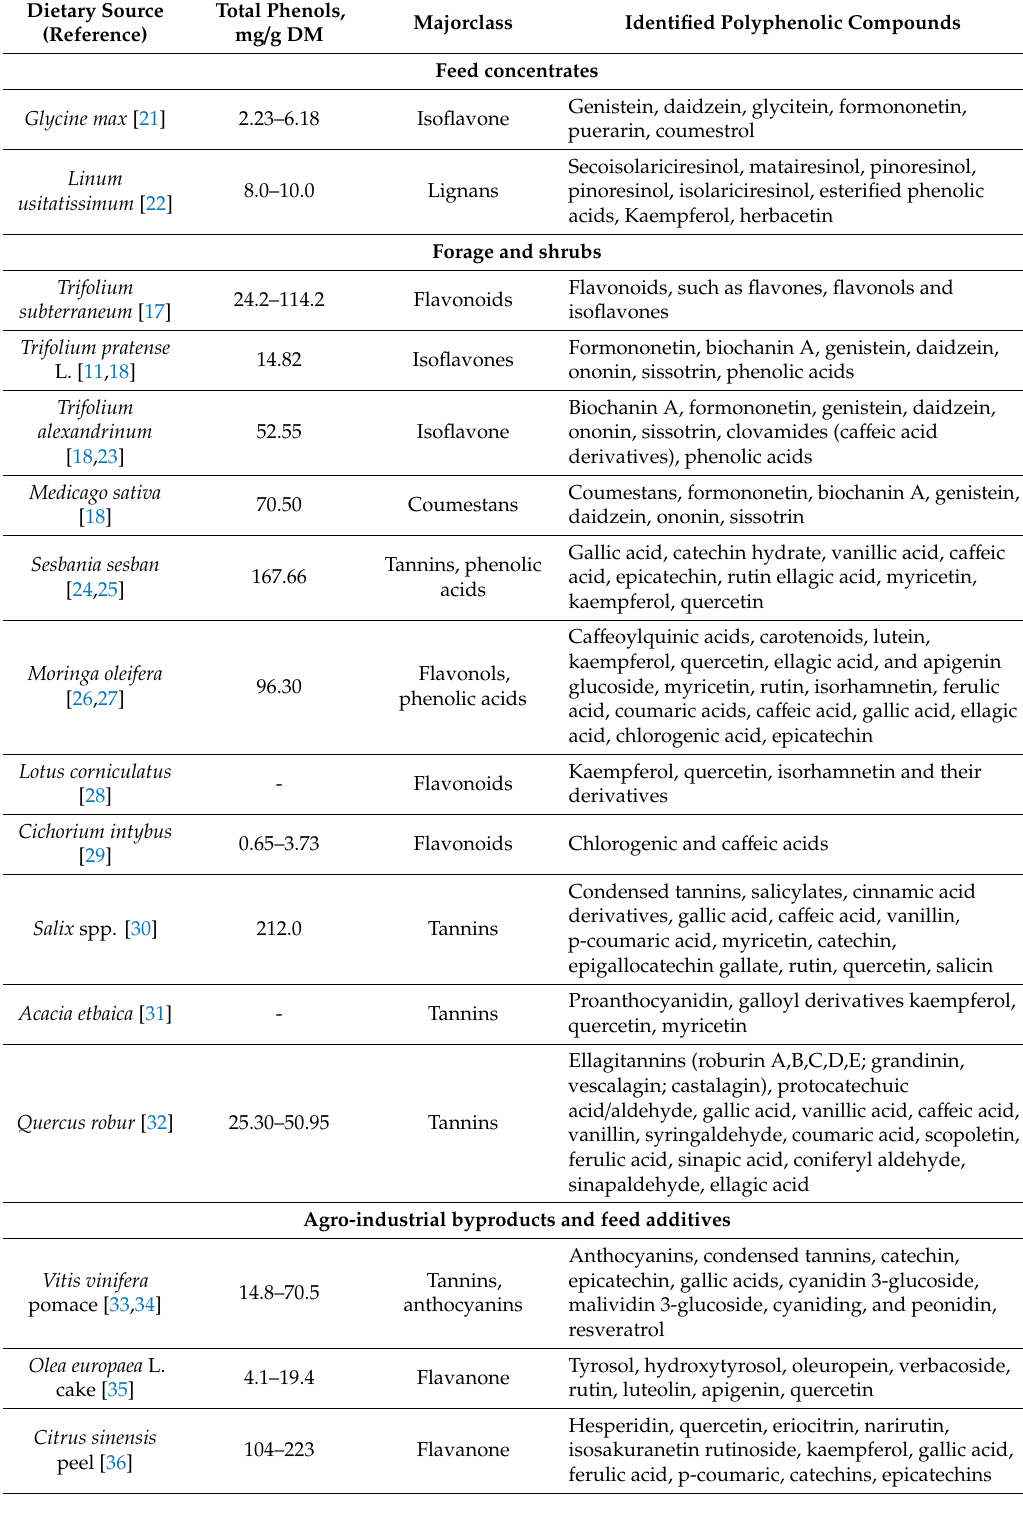
Table 1. Sources of polyphenolic compounds in feed ingredients of farm